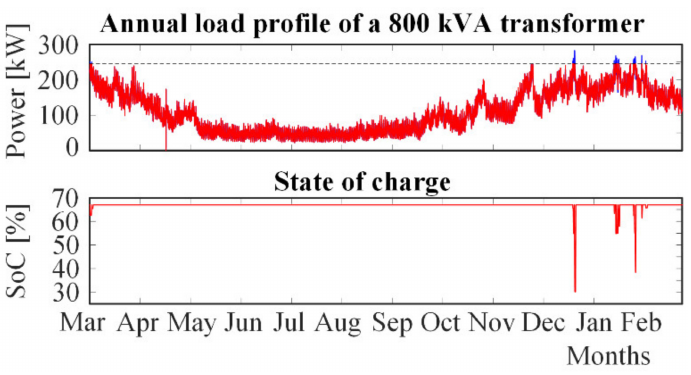
Figure 13. Peak-shaving at the transformer LV side by using an aggregated BESS.